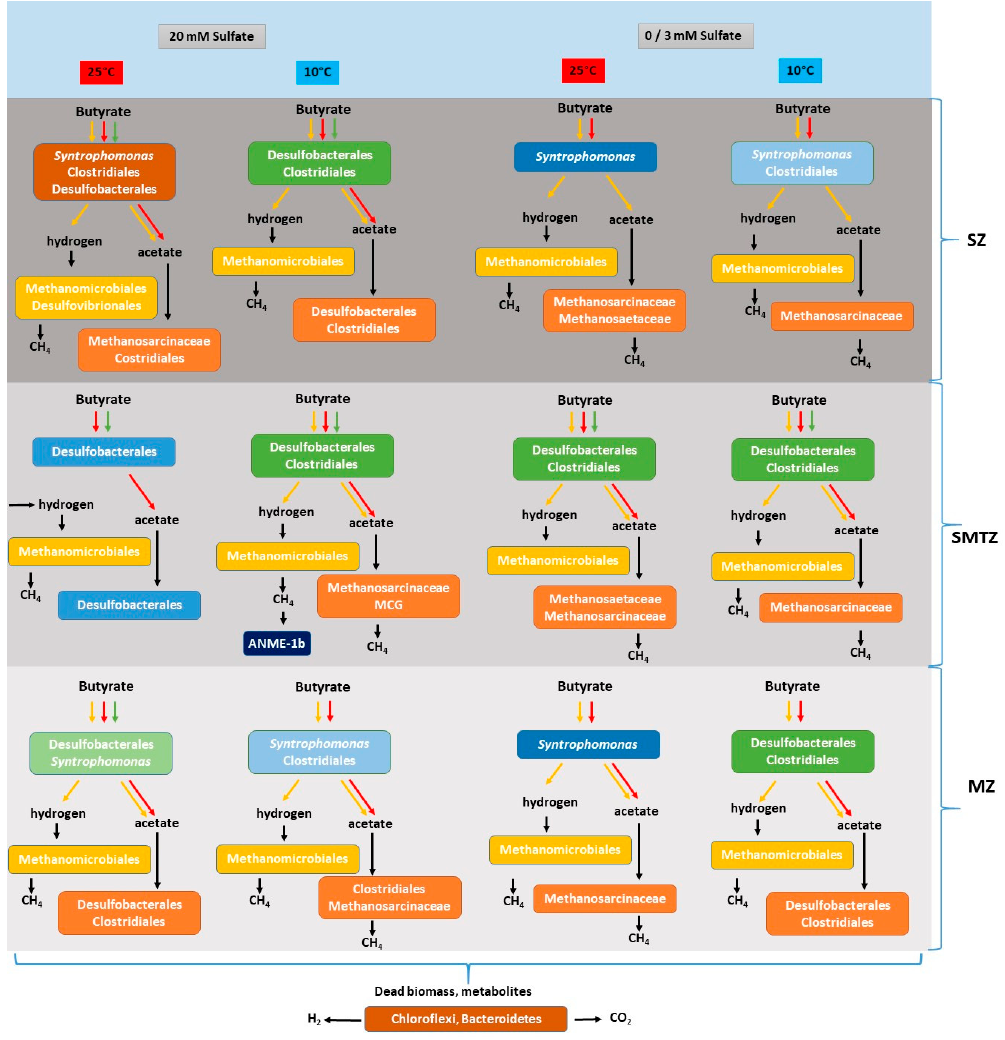
Figure 6. Overview of butyrate conversion and the proposed responsible microbial community at different temperatures and sulfate concentrations in enrichment slurries of sulfate, sulfate–methane transition, and methane zone sediment of Aarhus Bay. Possible butyrate conversion pathways are shown with different colored arrows; red arrows represent incomplete butyrate conversion coupled to sulfate reduction, green arrows represent complete butyrate conversion coupled to sulfate reduction, yellow arrows represent syntrophic butyrate conversion. Horizontal arrow represents the substrates originated from fermentation, decomposition of dead biomass, and/or metabolites.